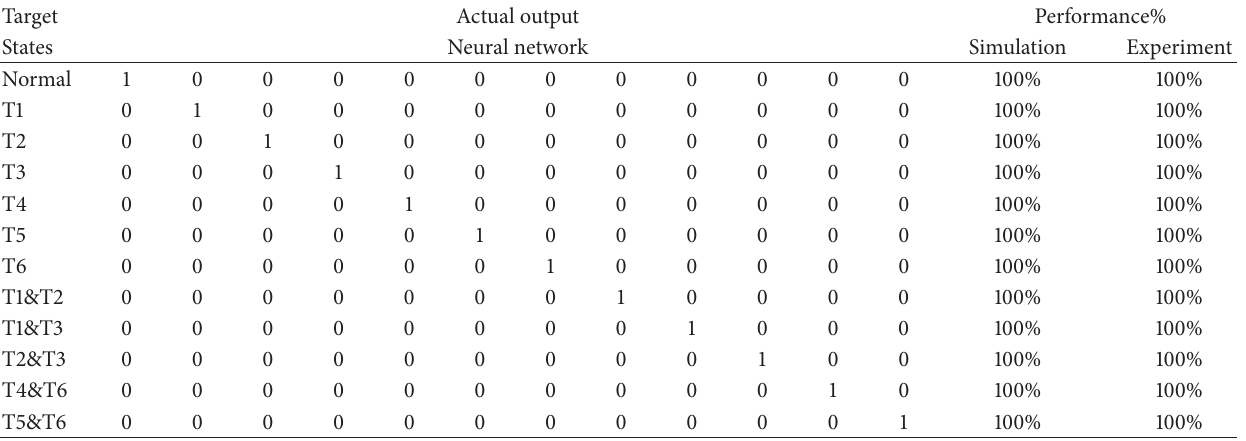
Table 3: Performance table for ANN based fault detection and diagnosis system.